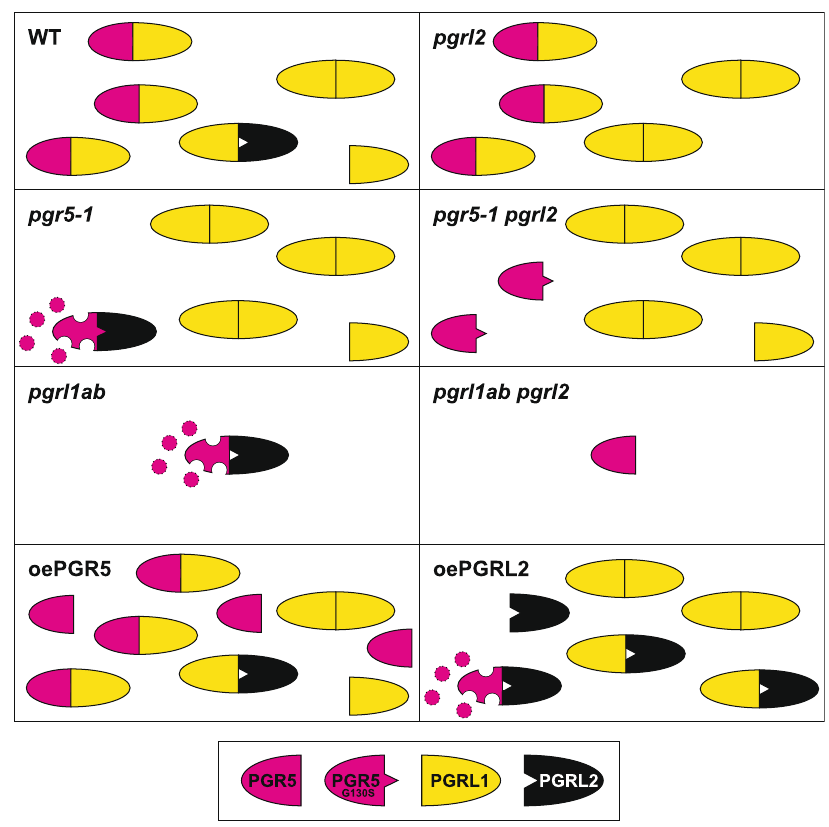
Fig. 8 Model for PGRL1-PGRL2-dependent regulation of PGR5 accumulation. This model is based on the following observations and assumptions (see main text). (i) The ratios of PGRL1 to PGR5 to PGRL2 in WT cells are approximately 70:10:<1. (ii) PGRL1 and PGR5 form heterodimers to stabilize